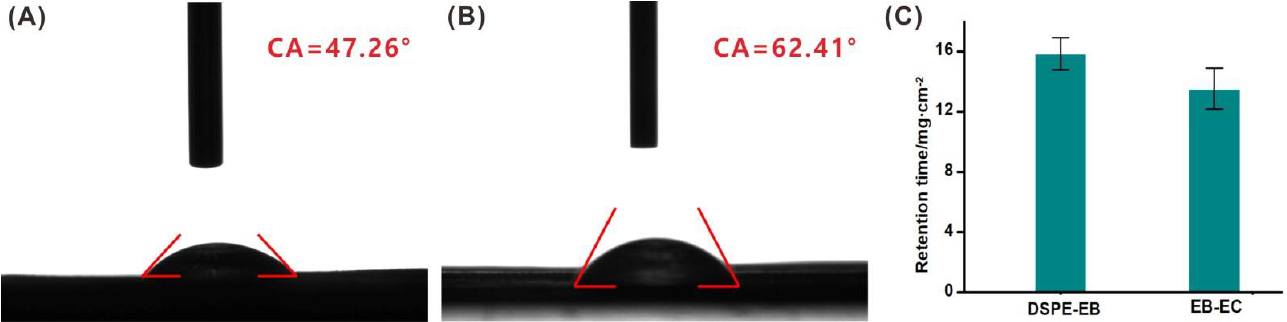
Figure 2. Contact angle of DSPE-EB nanoparticles ( A ) and EB-EC ( B ) on the surface of maize foliage; ( C ) the retention of the DSPE-EB nanoparticles and EB-EC solutions on maize leaves.